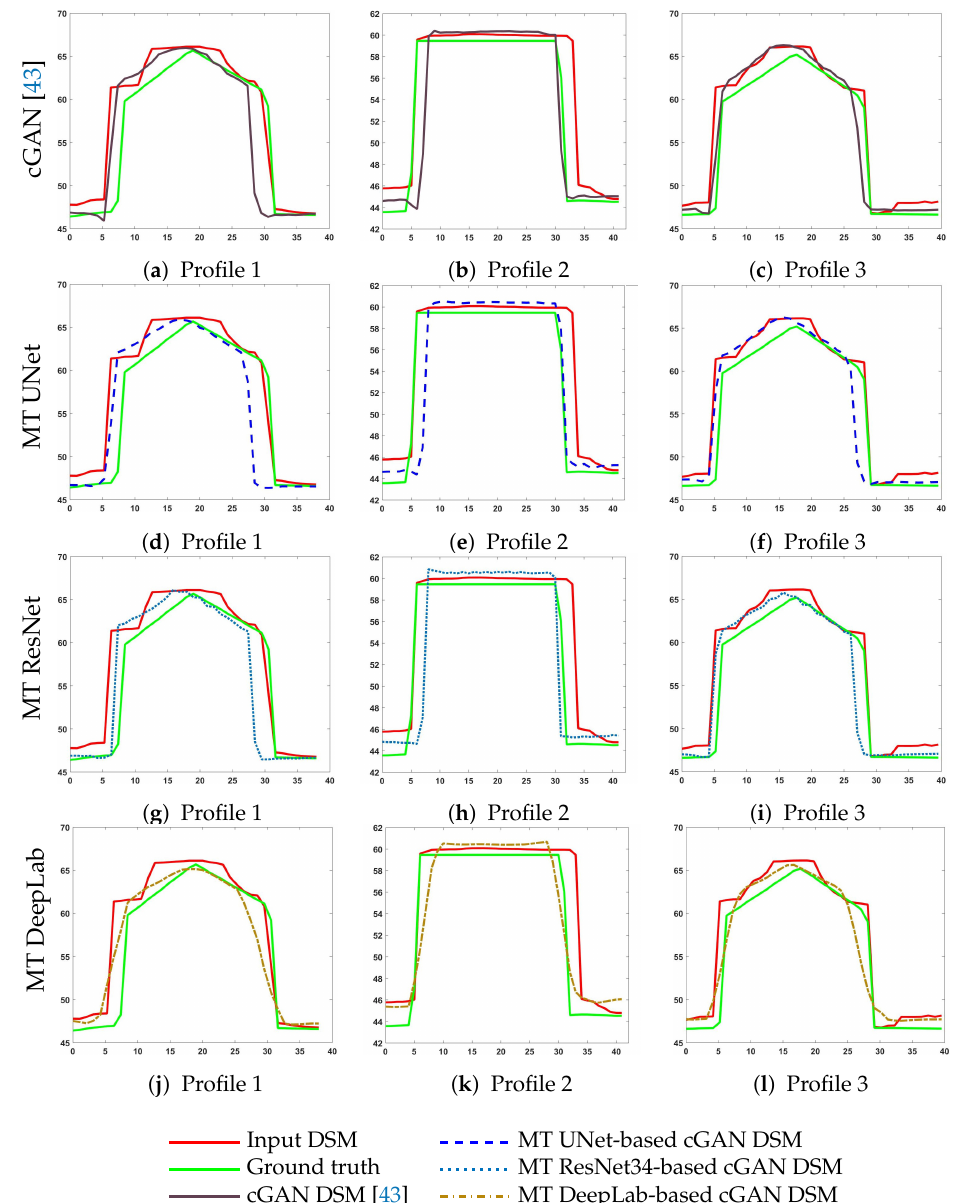
Figure 6. Illustration of the profiles for three selected buildings (cf. Figure 3c) from DSMs generated by ( a – c ) the cGAN model [43], ( d – f ) the multi-task only UNet-based cGAN, ( g – i ) the multi-task only ResNet34-based cGAN, and ( j – l ) the multi-task only DeepLabv3+-based cGAN. The results from the second, third, and fourth lines are generated by a one-generator, two-output network, depicted in Figure 2a. MT,